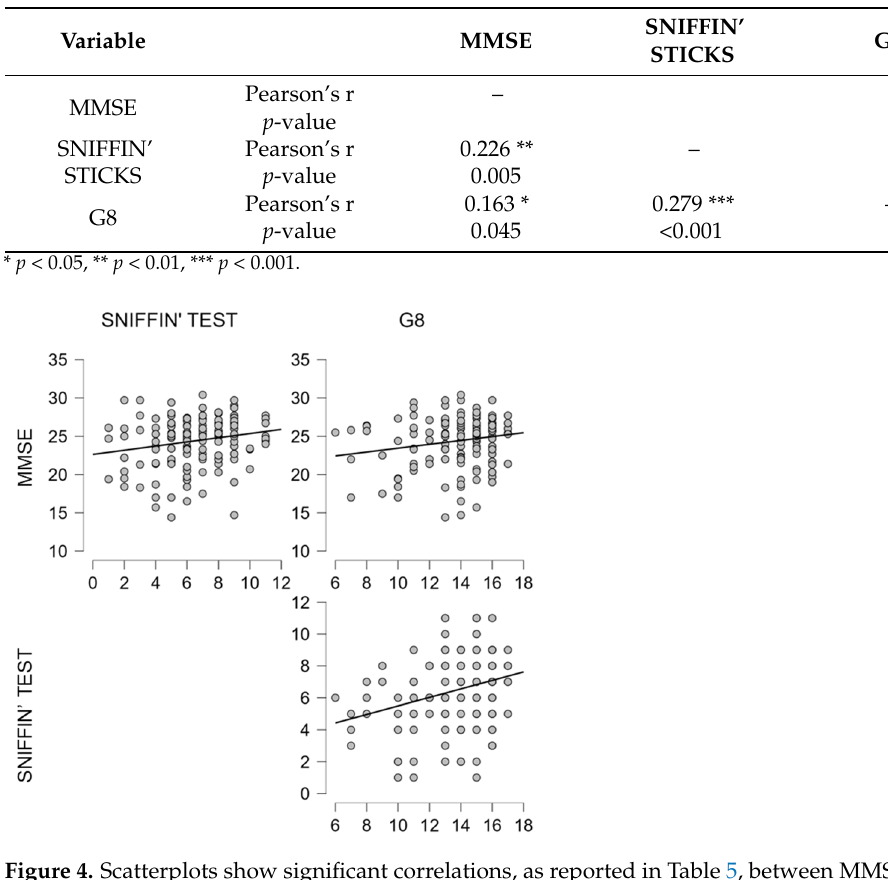
test and G8. test and